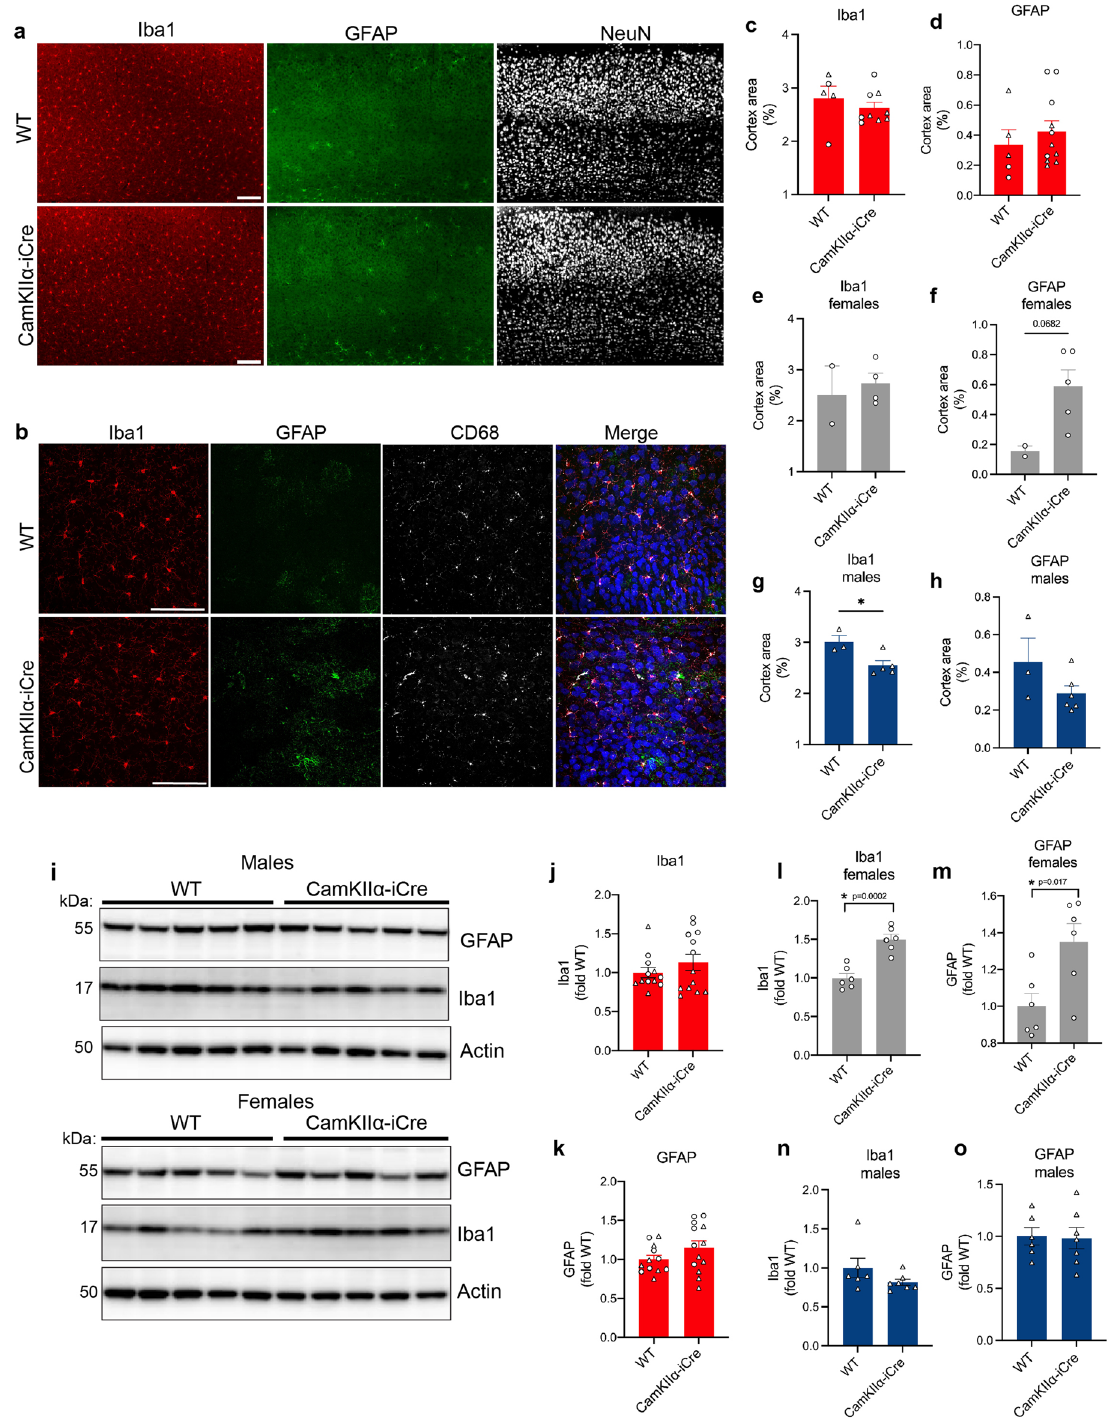
Figure 2. Increased expression of Iba1 and GFAP in the cortex of female CaMKIIα-iCre expressing mice. (A) Immunofluorescence microscopy of representative coronal brain sections showing the cortex from 8-month-old female WT and CaMKIIα-iCre mice labeled for Iba1 (red), GFAP (green) and NeuN (white). Scale bar, 100 µm. (B) High magnification confocal microscopy images of layer 5 cortex region in ( A) showing Iba1 (red), GFAP (green), CD68 (white) and NeuN (blue) immunostaining. Scale bar, 100 µm. Quantification of layer 5 cortex Iba1 and GFAP immunostaining as a percentage of area covering the cortex from WT and CaMKIIα-iCre mice for males and females combined (C,D) and individually analyzed for females (E,F) and males (G,H) (WT, n = 5; CaMKIIα-iCre, n = 9–11). (I) Immunoblot of cortical homogenates from 8-month-old male (upper) and female (lower) WT and CaMKIIα-iCre mice probed for GFAP, Iba1 and actin. Original immunoblots are shown in Fig. S3C. Quantification of Iba1 (J) and GFAP (K) immunoblots in ( I ) for males and females combined and individually analyzed for females (L,M) and males (N,O) normalized to actin and expressed as fold of WT (male WT, n = 11; CaMKIIα-iCre, n = 12). Circles = females, triangles = males. Unpaired t-test was performed for all quantifications and values are mean ±